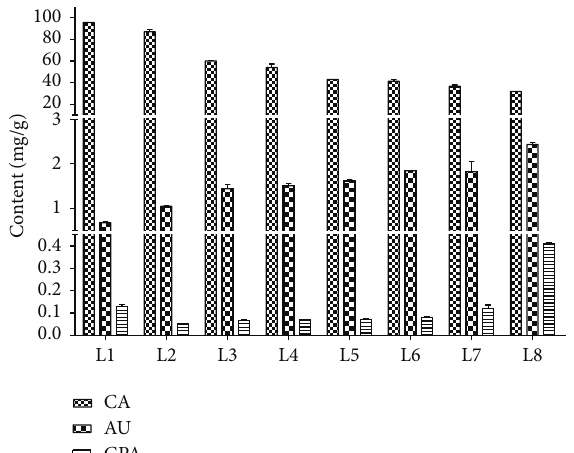
Figure 6: Content of catalpol, aucubin, and geniposidic acid in different developmental stages of Beijing No. 1